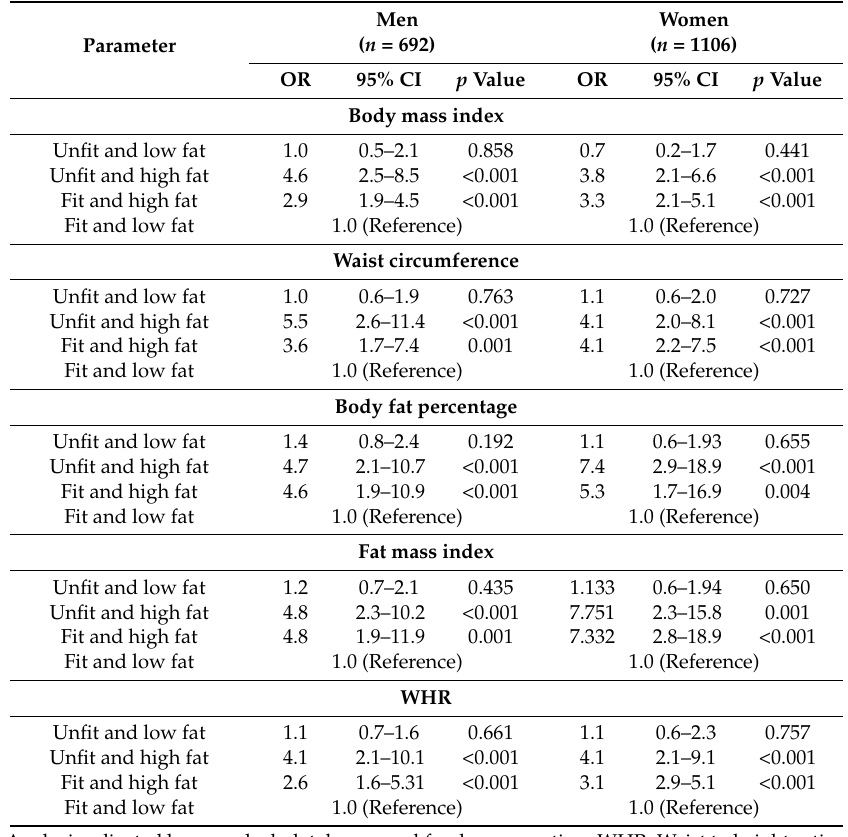
Table 3. Combined effects of muscular fitness and fatness parameters on high cardio-metabolic risk.